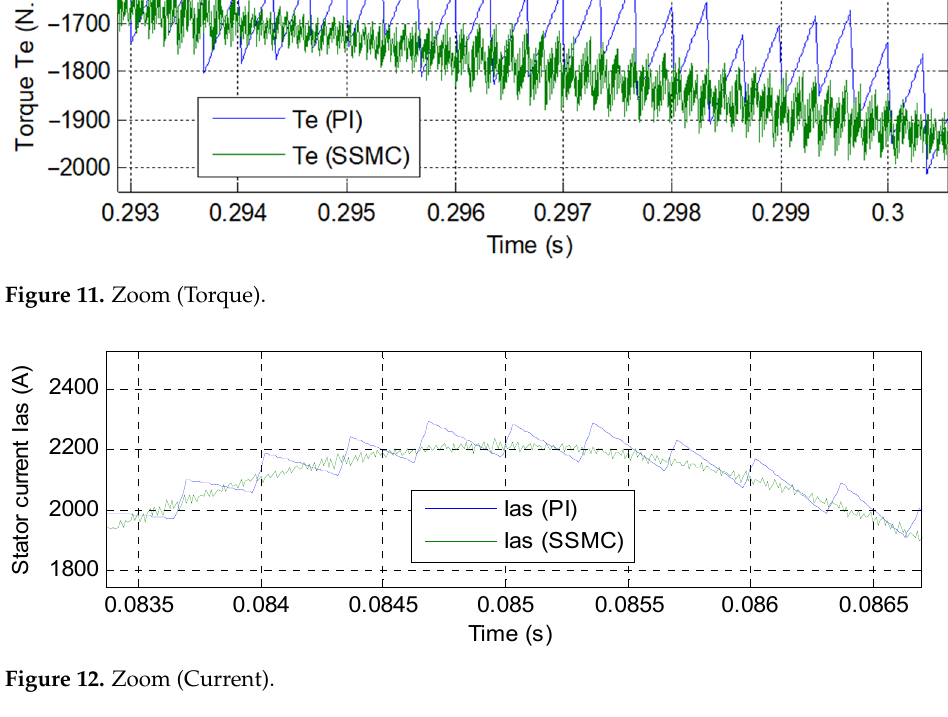
Figure 13. THD (direct FOC method).